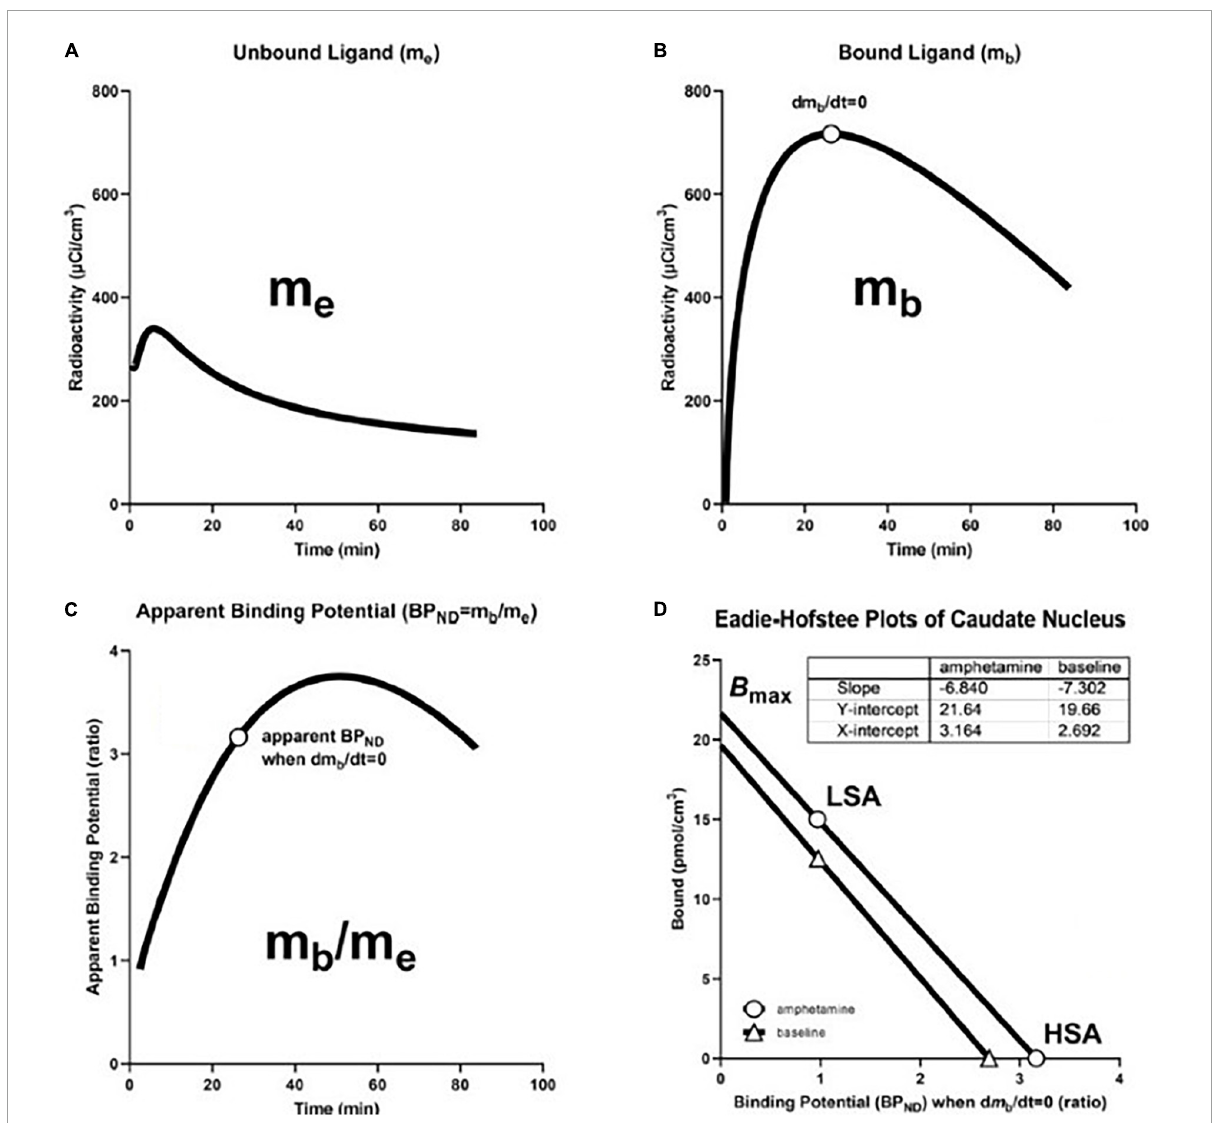
FIGURE6 Transient Receptor EquilibriuM BoLus Estimation (TREMBLE): From precursor pool to maximum binding capacity. (A) Shows model-derived quantity of unbound tracer in precursor pool ( m e ) in caudate nucleus of brain of human volunteer participant in study of amphetamine effects on receptor binding of [ 11 C]raclopride. (B) Shows model-derived quantity of specifically bound radioligand ( m b ) Circle indicates time of transient equilibrium of binding. (C) Shows ratio of m b and m e as measure of apparent binding potential ( BP ND ). Circle shows true binding potential at time of transient equilibrium of binding. (D) shows Eadie-Hofstee plots of binding at baseline and after amphetamine administration at high and low specific activities of [ 11 C]raclopride that yield estimates of half-saturation quantities and maximum binding capacities in the absence and presence of amphetamine. Based on Sølling et al. (1997) and adapted from Wong et al.